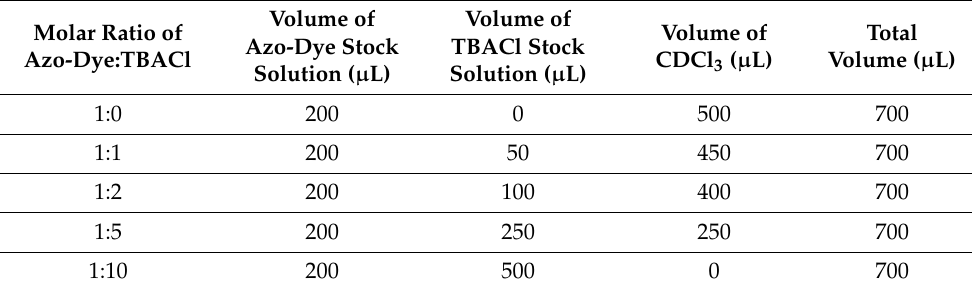
Table 3. 19 F-NMR titration of azo dyes with tetrabutylammonium chloride salt.